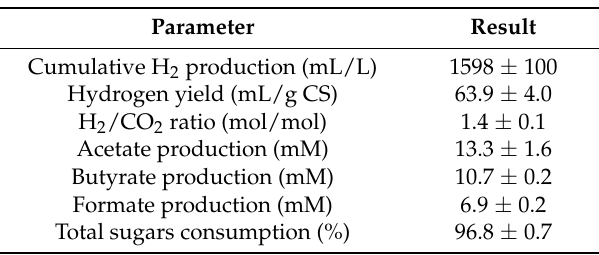
Table 2. Sugars consumption, H 2 and organic acids production in the fermentation of detoxified CS hydrolyzate by C. butyricum